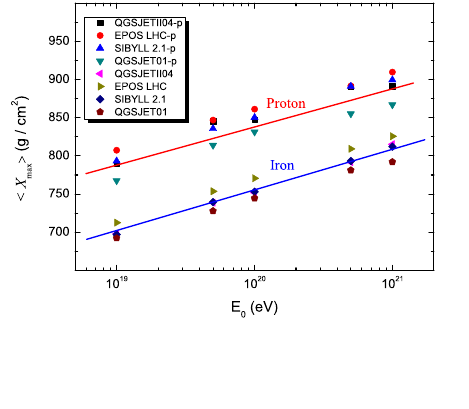
Figure 7. The maximum charged particles number N max as func- tion of the zenith angle of primary proton (Black) iron (red) with energy equals 10 20 eV